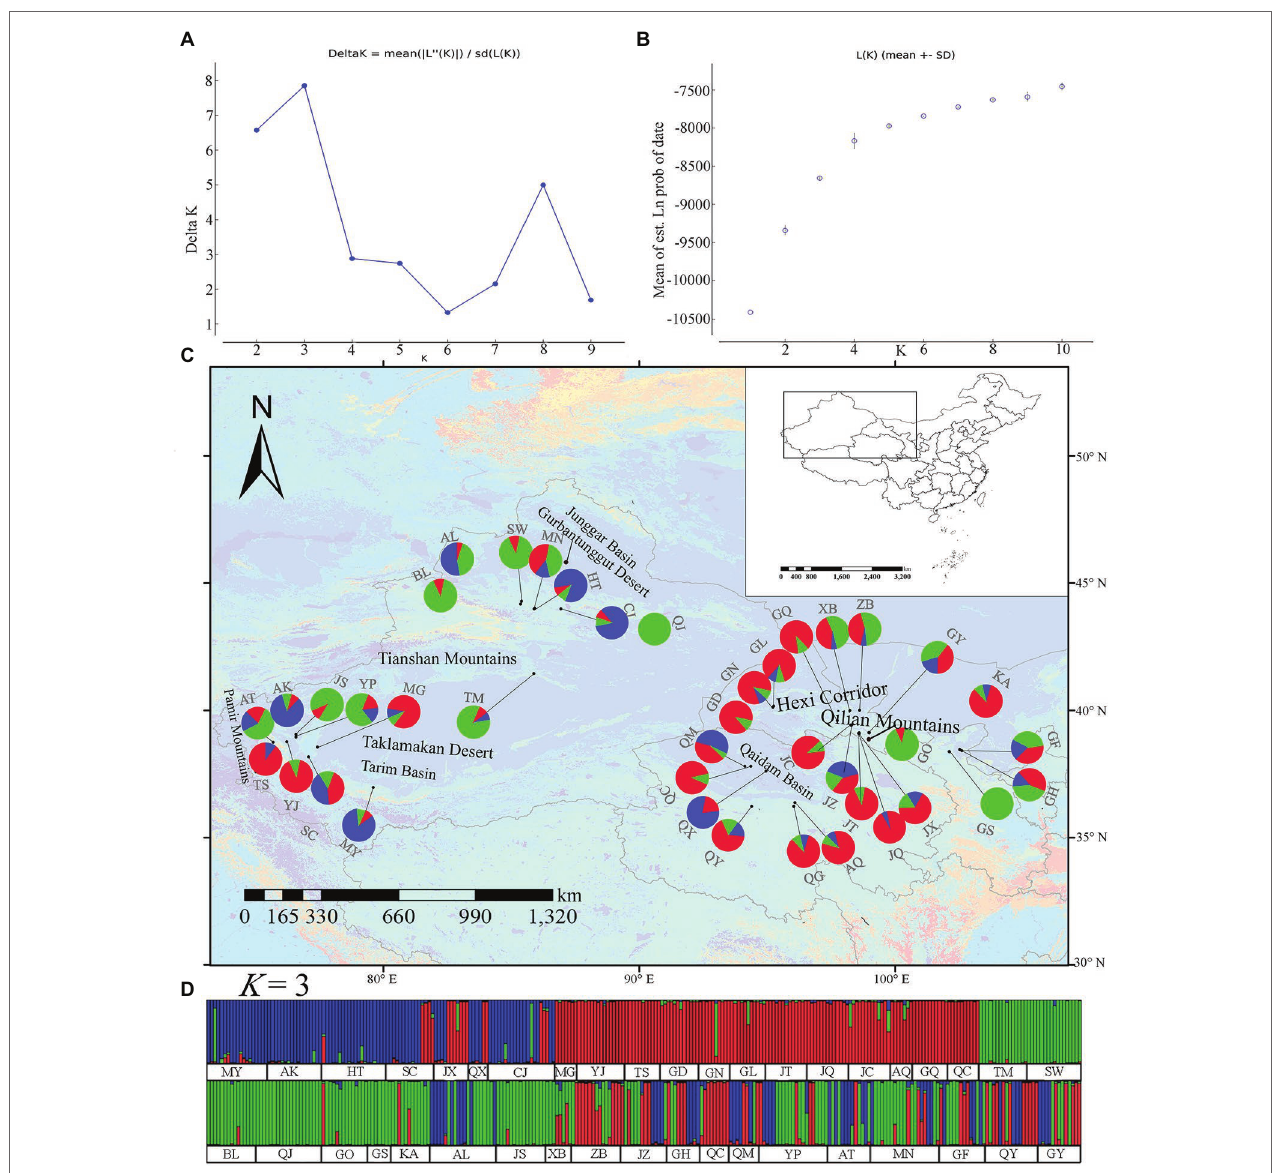
FIGURE 1 | Genetic divergence in 40 Lycium ruthenicum populations based on 11 EST-SSR datasets. (A) Log-likelihood values. Ln P ( K ) as a function of K calculated for 10 replicates. (B) Second-order changes in the log-likelihood values. (Delta K ) as a function of K calculated for 10 replicates. (C) Geographical distribution of three genetic clusters ( K = 3) and genetic cluster composition in each population. (D) Proportion of genetic clusters at K = 3 for each of 540 individuals. Smallest vertical bars represent